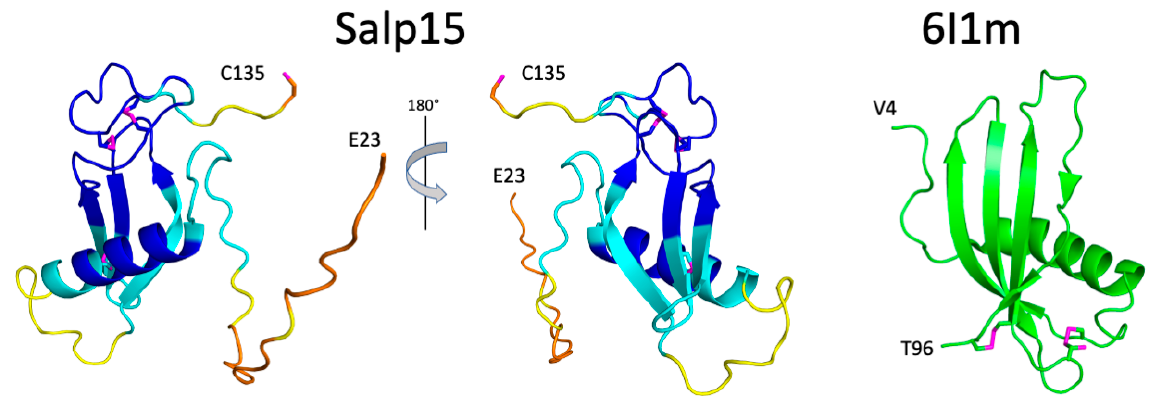
Figure 3. Structural model of Salp15 and similarity with Protein Data Bank entry 6I1m. ( Left ) Al- phaFold predicted structure for residues 23–135 of Salp15. The color code of the main chain follows that used by AlphaFold to report the reliability of the models. Blue, cyan, yellow, and orange protein regions correspond to very high (LDDT > 90), high (90 > LDDT > 70), low (70 > LDDT > 50), and very low (LDDT < 50) model confidence, respectively. The side chains of the seven cysteine residues are shown as sticks, with the sulfur atoms in magenta. Only the C-terminal C135 side chain is reduced (according to NMR chemical shifts). The depicted secondary structure is that identified by DSSP. ( Right ) Crystal structure of secreted type 1 cystatin from F. hepatica . The side chains of the four cysteines are shown in sticks with the sulfur atom in magenta. C66 is modeled in two conformations (both are shown). The depicted secondary structure is that identified by PyMol. The N- and C-ter- minal residues are indicated for both proteins.